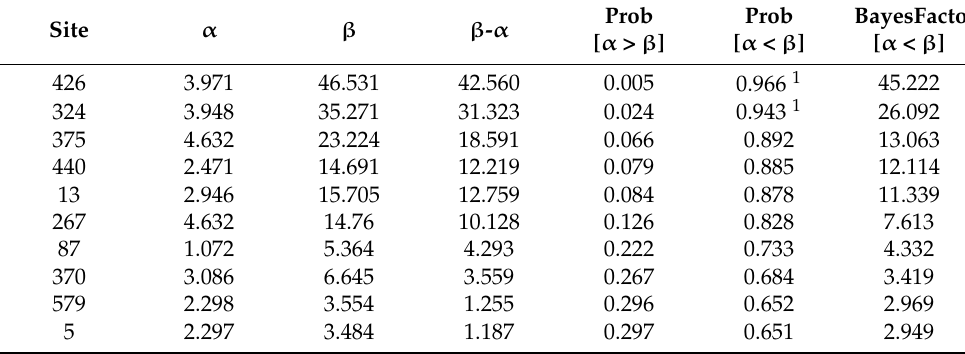
Figure 5. The VP2 variants and structure between the FPV and CPV-2/-2a/-2b/-2c variants. ( A ) The variants and amino acid variation sites in the VP2 gene. ( B ) A VP2 tertiary model of the variants. Amino acids are represented by single-letter abbreviations. The site at position 426 (yellow color), located at the top of the protrusion region of the loop 4 structure [27], is the signature site that distinguishes CPV-2a (Asn), -2b (Asp), and -2c (Glu). The five specific sites at 87Met, 101Ile, 297Ser, 300Ala, and 305Asp for CPV-2 variants were labeled with green color in B. The characteristic mutations of 5Gly, 267Tyr, 324Ile, and 370Arg in the new Asian CPV-2c variant are marked with red color in ( B ).